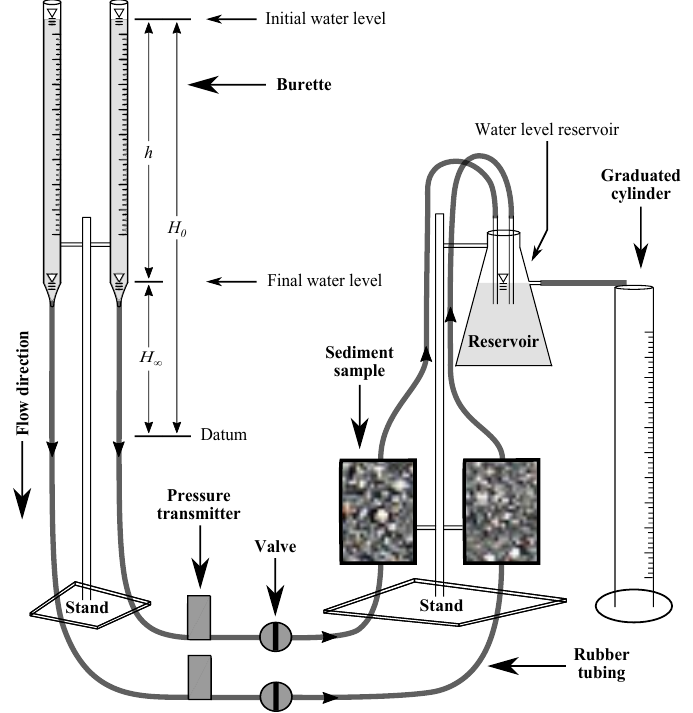
Figure 2. A schematic of the laboratory permeameter setup for permeability